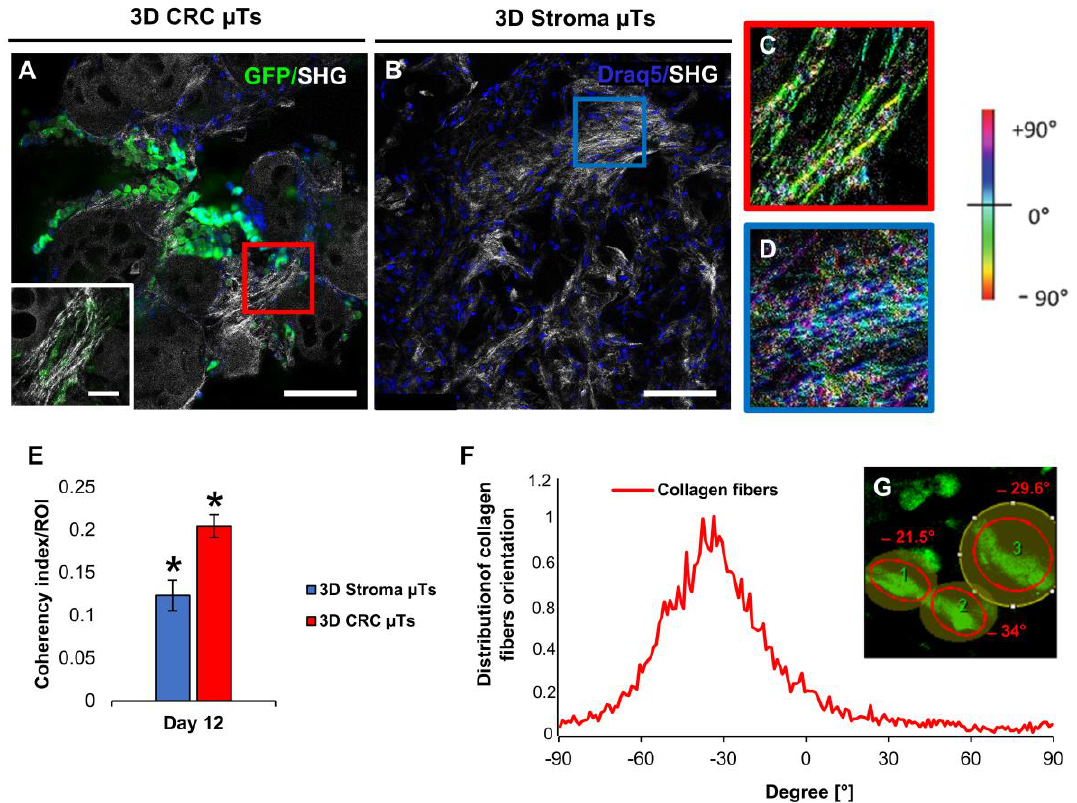
Figure 5. Collagen fiber orientation analysis of the 3D CRC μTs and 3D Stroma μTs on day 12 of culturing. ( A , B ) The confocal images of the 3D CRC μTs with a high magnification inset (scale bar 40 µm) and 3D Stroma μTs , respectively; green fluorescent protein (GFP) expressed by HCT-116 cells (green), nucleus of HCT-116 and Normal Fibroblasts/Cancer-Associated Fibroblasts (blue), and collagen Second Harmonic Generation (SHG) signal (gray); scale bar: 150 µm. ( C , D ) Color map of the collagen fibers organization in the 3D CRC μTs (red perimeter) and the 3D Stroma μTs (blue perimeter) insets; scale bar: 40 µm. ( E ) The coherency index/Region of Interest (ROI) graph of the 3D CRC μTs and 3D Stroma μTs. ( F , G ) Analysis of the distribution of collagen fibers orientation in the 3D CRC μTs. All the experiments were performed in triplicate (n = 3), and the values represent the mean and the mean standard error ( ∗ p < 0.05).